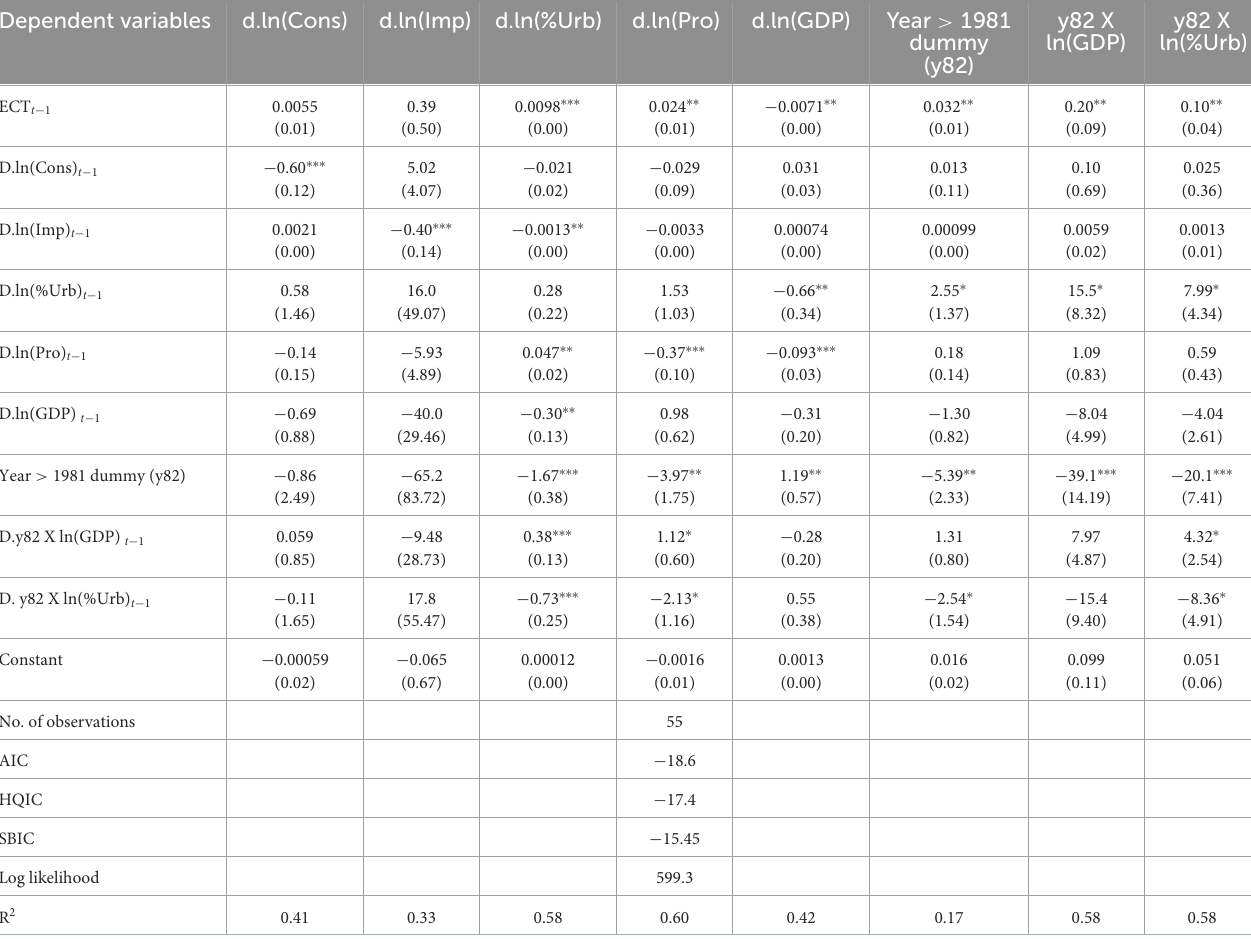
TABLE 5 Estimated functions applying the Vector Error Correction (VEC) model estimation procedure, explaining the relationship between yearly per capita wheat consumption, wheat import, % share of the urban population, domestic wheat production, and GDP per capita in India. Dependent